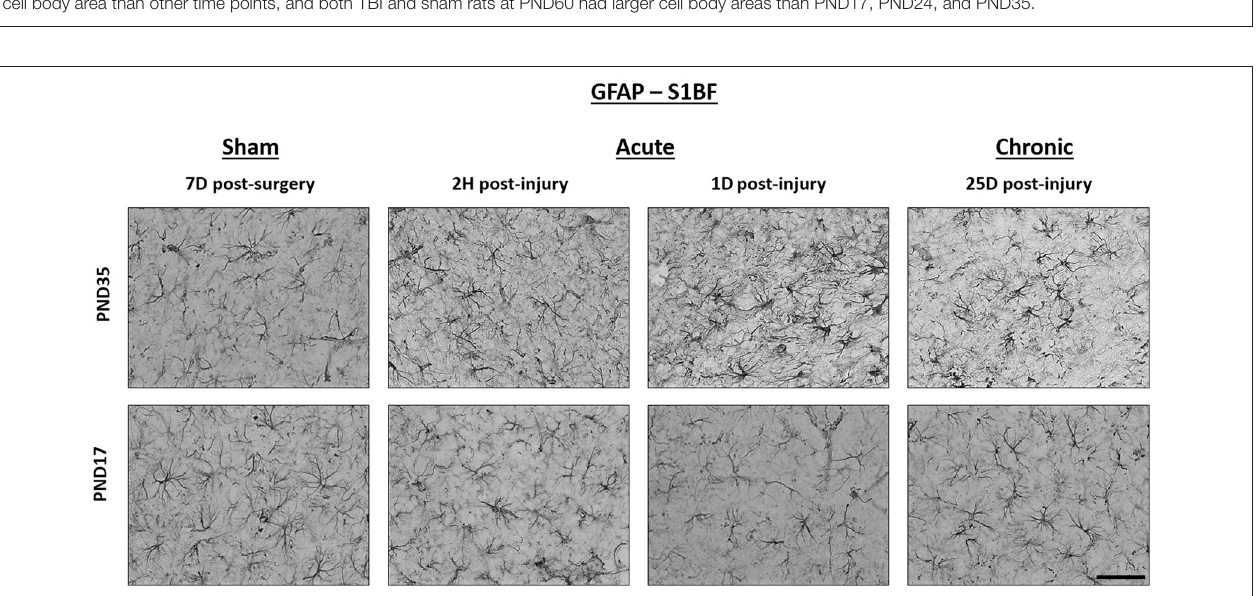
FIGURE 5 | post-injury. (B) TBI rats had shorter microglial branch lengths compared to shams at injury ages PND17 and PND35. PND35 TBI rats had longer microglial branch lengths than PND17 TBI rats. (C) TBI rats had shorter microglial branch lengths than shams at terminal ages PND24, PND42, and PND60. (D–F) There were no differences in the number of microglia between sham and TBI rats across times post-injury, injury ages, and terminal ages. (E) Both sham and TBI rats at PND35 had fewer microglia than PND17 rats. (G) The mean number of processes per microglia in sham and TBI rats across times post-injury were similar. (H) TBI rats had fewer mean processes per microglia than shams at injury ages PND17 an PND35, and PND35 TBI rats had more mean processes per microglia than PND17 TBI rats. (I) TBI rats had fewer mean processes per microglia than shams at terminal ages PND24 and PND42. (J–L) There were no differences between TBI and sham rats in cell body perimeter lengths among times post-injury, injury ages, or terminal ages. (M) Both TBI and sham rats at 43D post-injury had larger cell body areas than other times post-injury. (N) There were no differences in cell body area between TBI and sham rats between injury ages. (O) TBI rats at PND24 had smaller cell body area than other time points, and both TBI and sham rats at PND60 had larger cell body areas than PND17, PND24, and PND35.